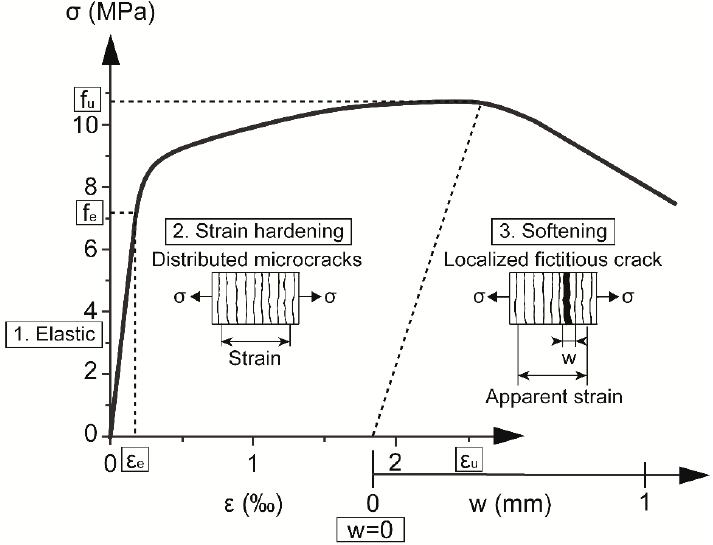
Figure 3. UHPFRC behavior under tension.